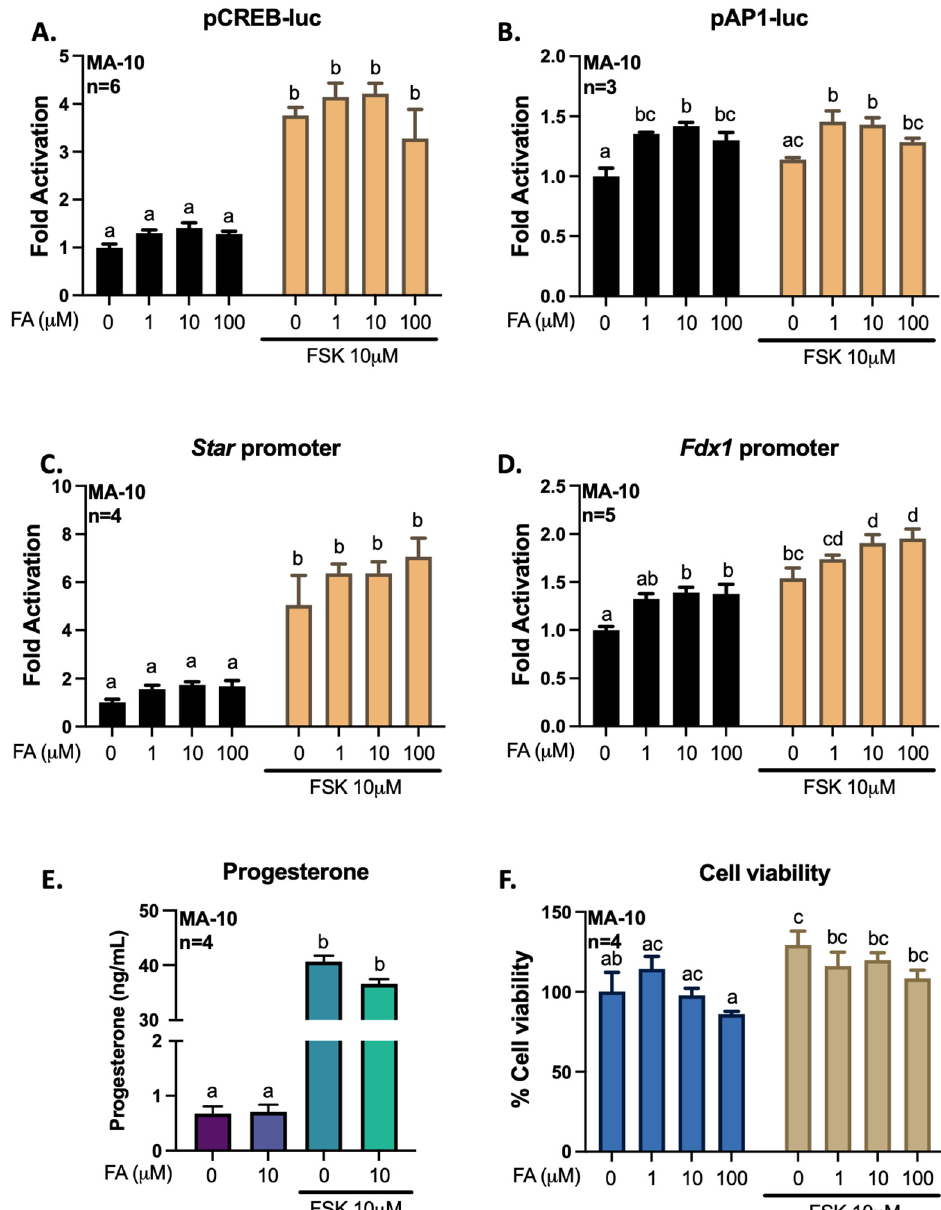
nificant difference ( p < 0.05).